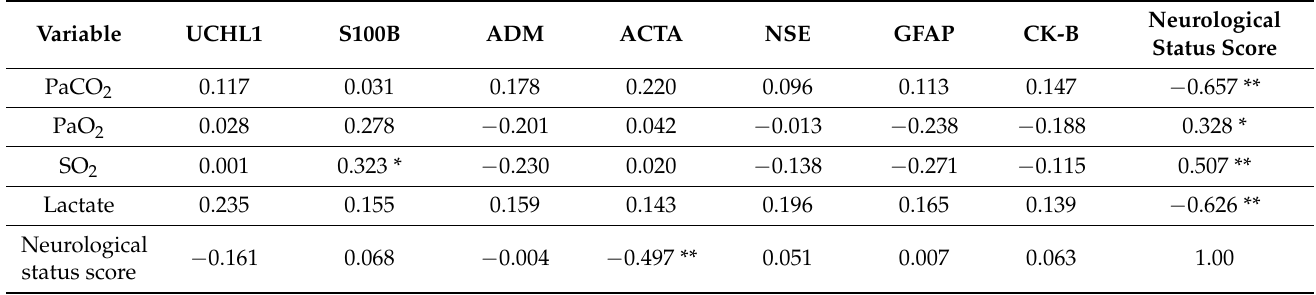
Table 5. Correlations between arterial blood gas variables, brain-related biomarkers, and neurological status score in healthy and calves with perinatal